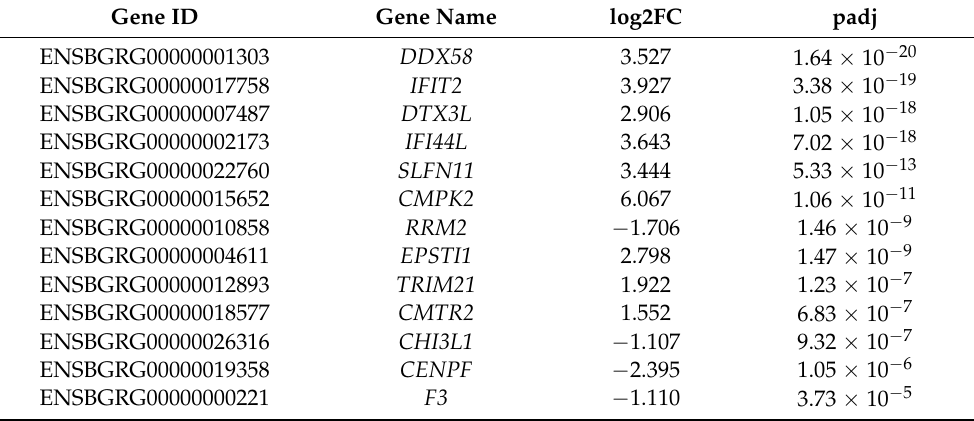
Figure 3. The ceRNAs network of lncFAM200B during the yak preadipocyte differentiation. The red color indicates up-regulated DEMs and DEGs, and the blue color indicates the down-regulated DEMs and DEGs after lncFAM200B overexpression. Table 1. The differential expression level of 29 common